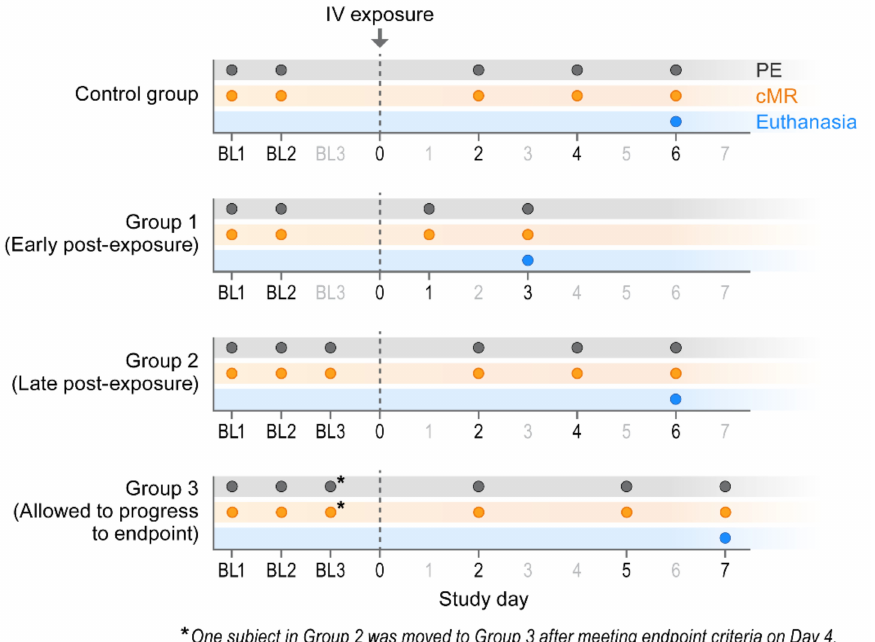
Figure 1. Experimental design. BL = baseline sampling, time points prior to intravenous (IV) cowpox virus (CPXV) exposure. PE = physical exam, cMR = cardiac magnetic